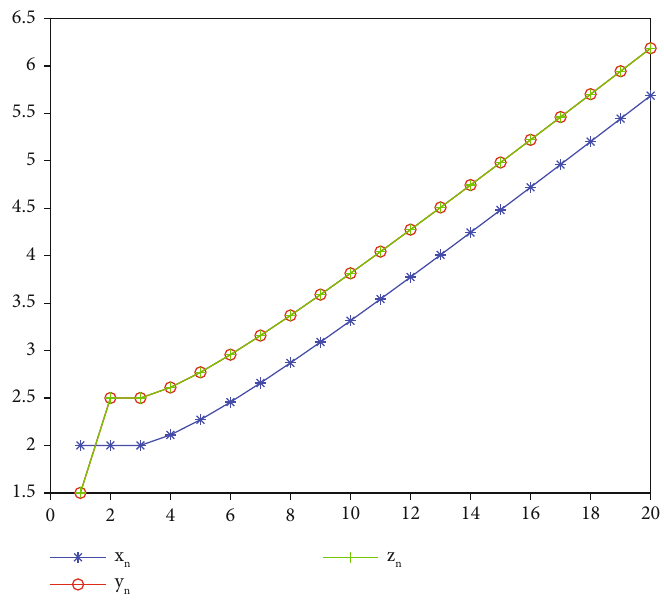
Figure 4: Convergence behavior f x